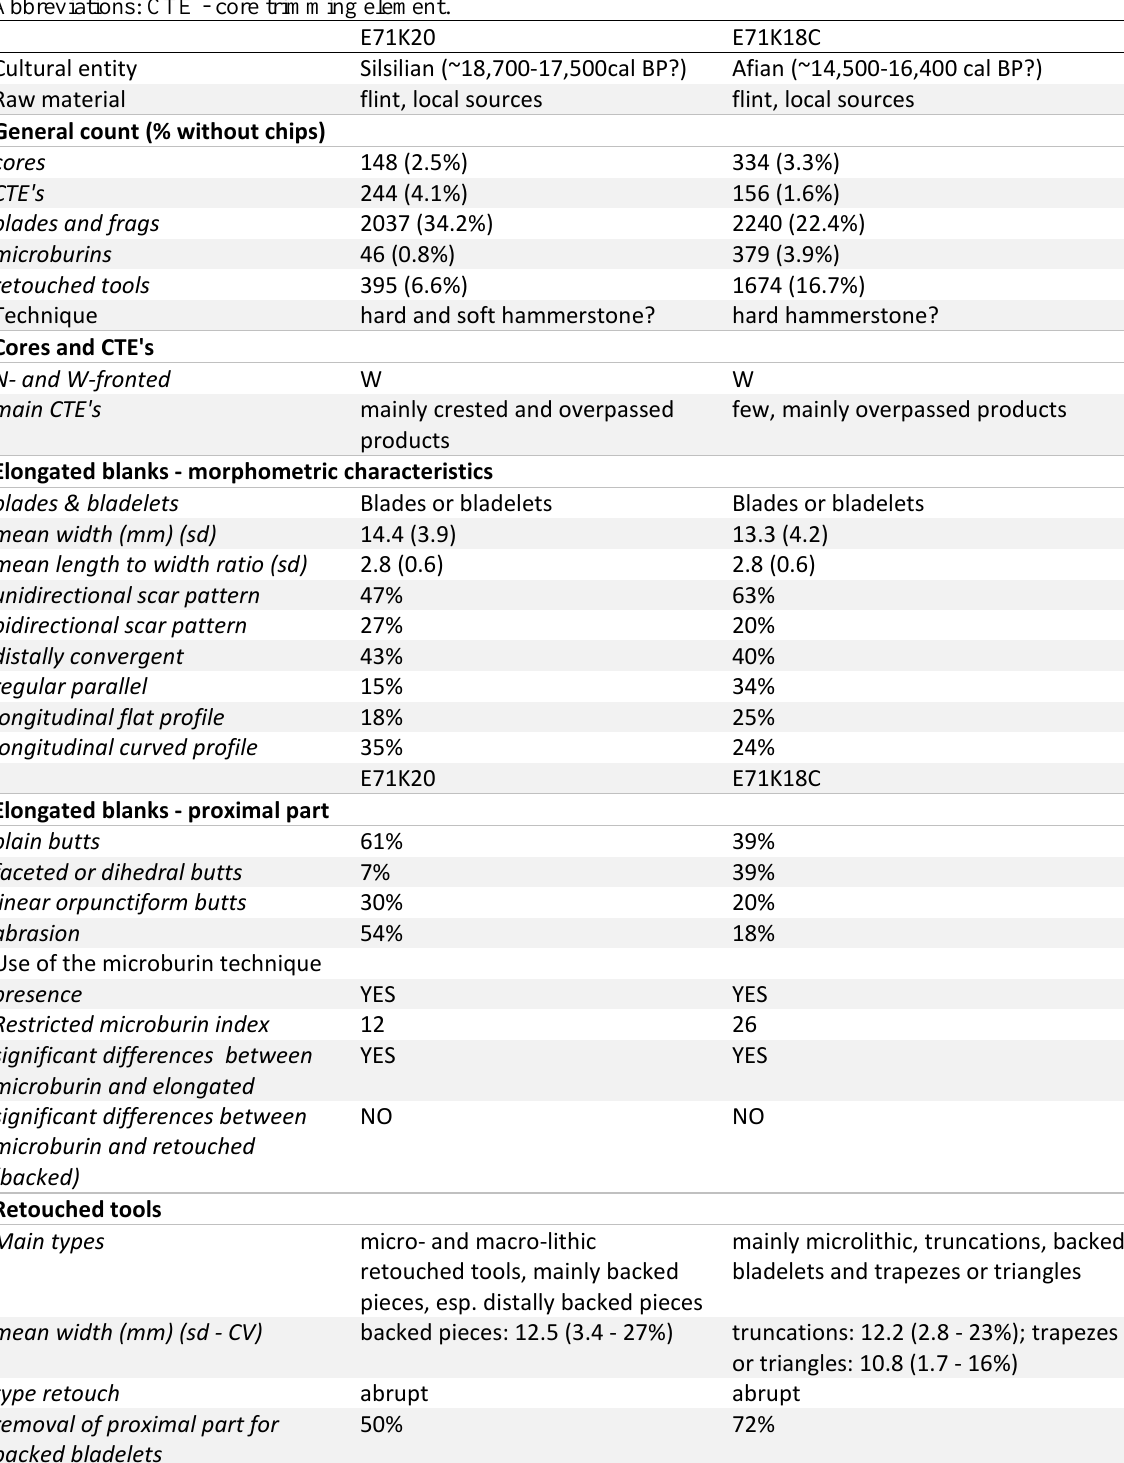
Table 15. Main characteristics of the assemblages of E71K18C and E71K20 (After Leplongeon, 2017). Abbreviations: CTE - core trimming